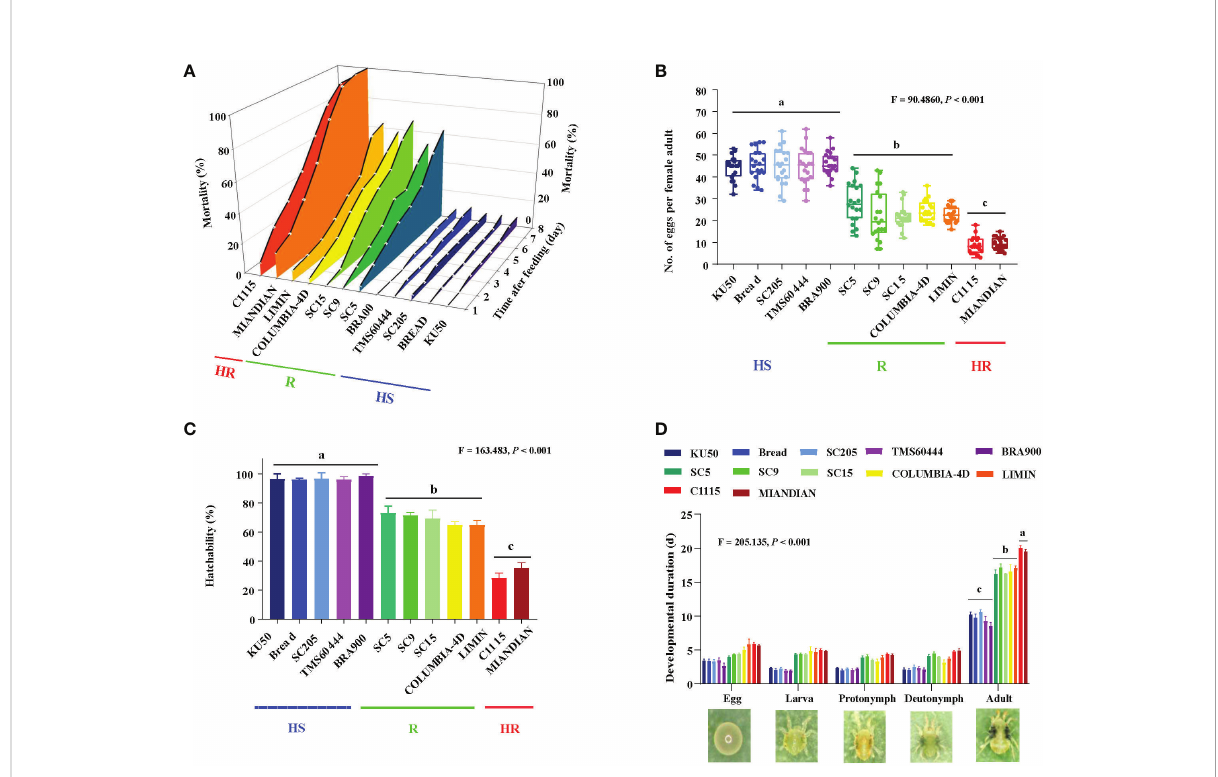
FIGURE 3 Effect on the reproduction and development of two-spotted spider mite (TSSM) while fed on different cassava varieties. (A) Mortalities of TSSM at 8 days post-infestation, (B) number of eggs per female adult, (C) hatchability, and (D) developmental duration. All data were fi rst subjected to a homogeneity test and were log- or square root-transformed if they did not meet the assumptions of normality and homoscedasticity. Different letters indicate signi fi cant differences among batches of HR, R, and HS varieties; all analyses were based on one-way analysis of variance with Tukey ’ s honestly signi fi cant difference multiple comparison test ( P < 0.05). The F - and P -values were presented in each